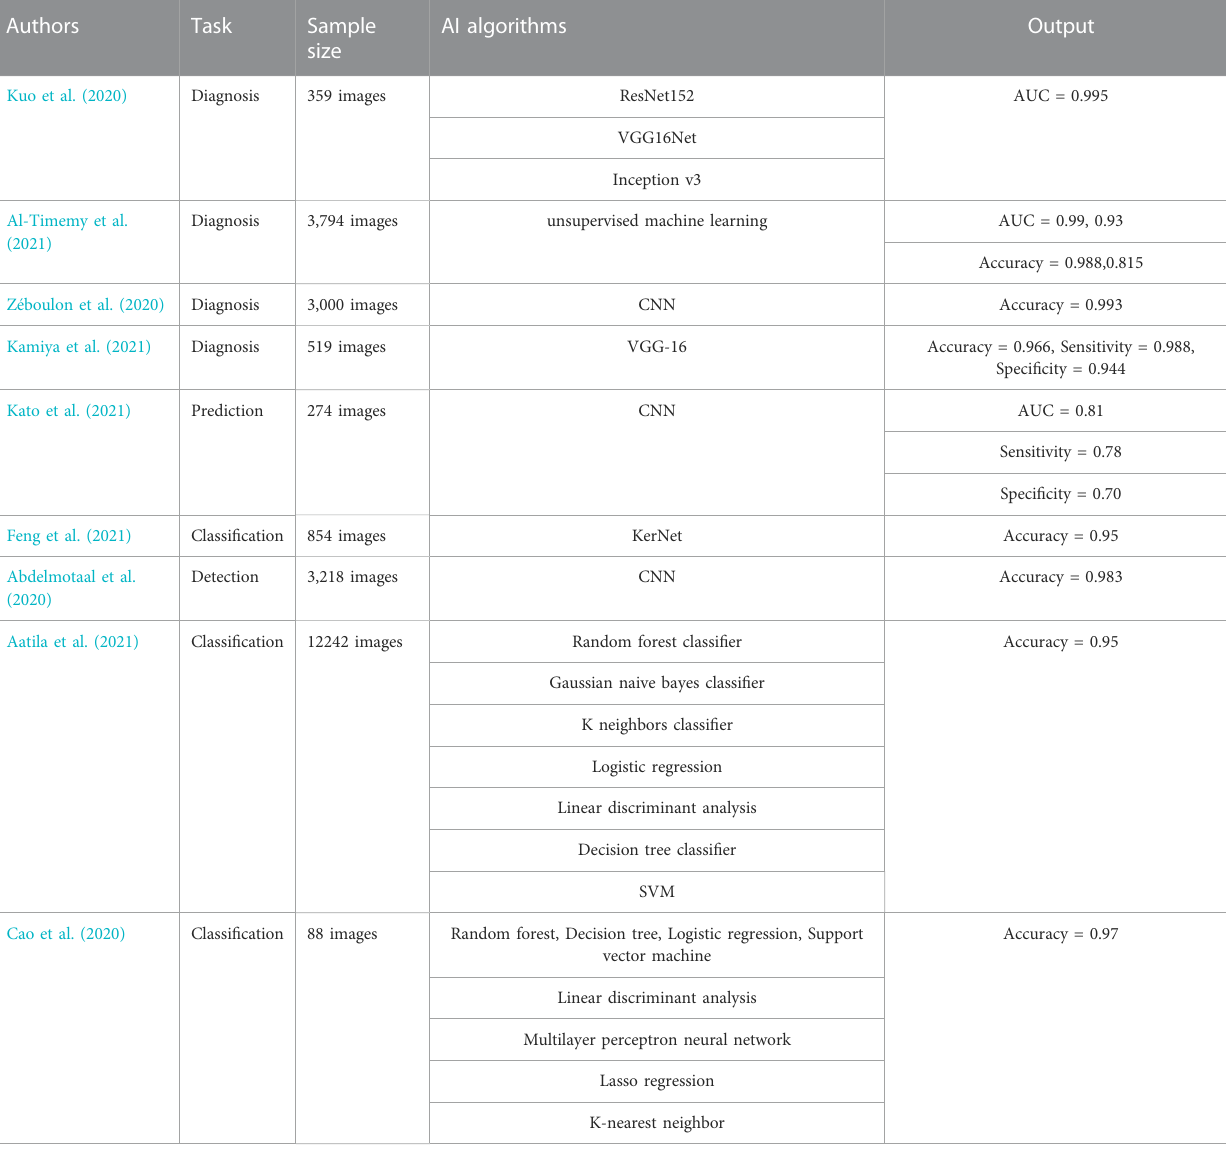
TABLE 3 Application summary of different AI models and algorithms in keratoconus.